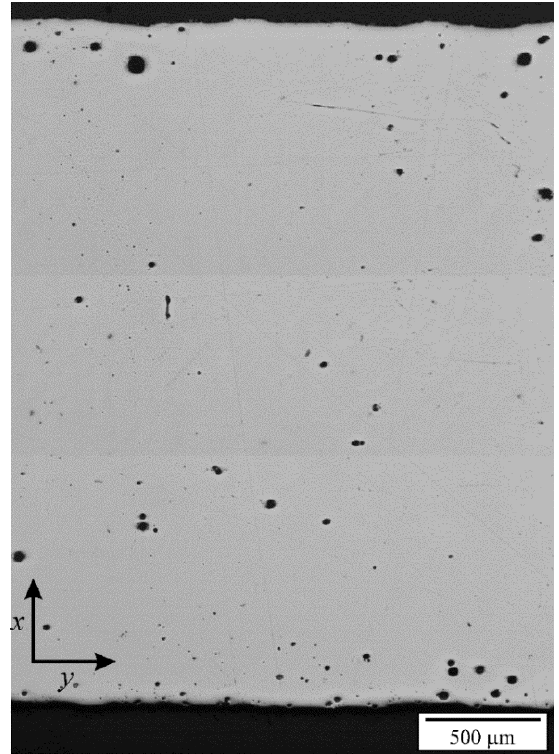
Figure 5. A light micrograph of the polished specimen [39].